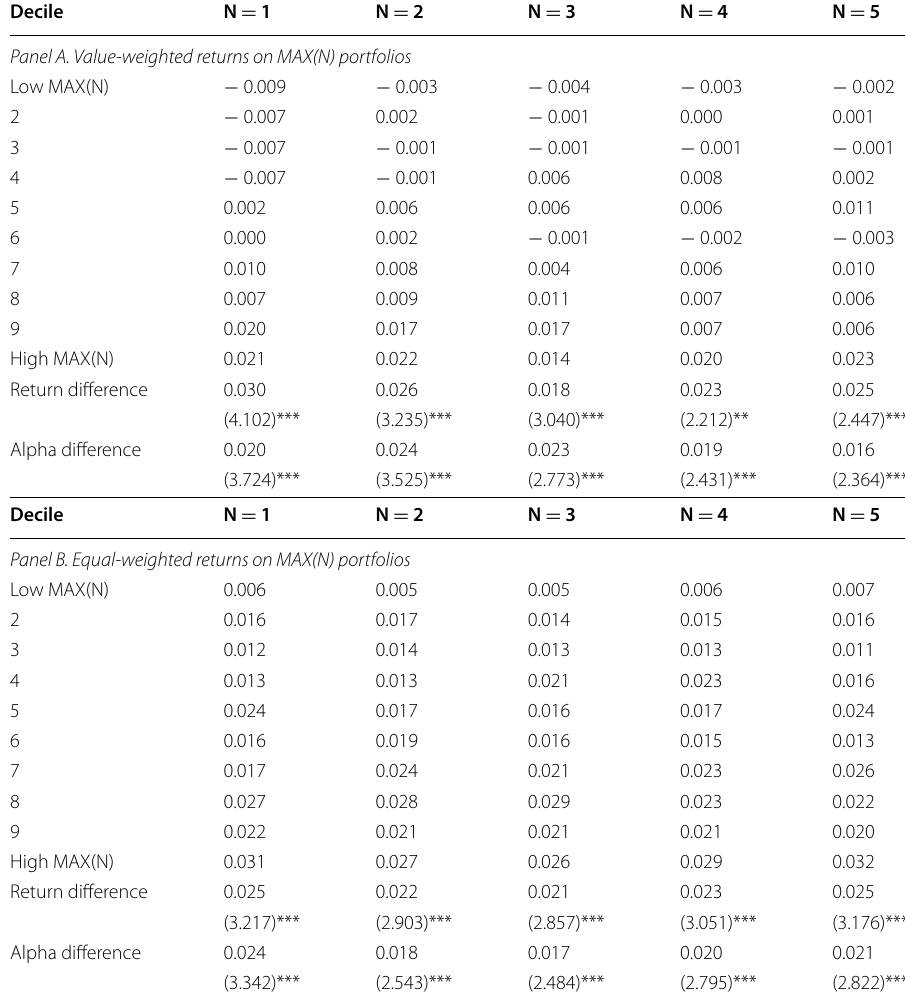
Table 3 Returns on portfolios of cryptocurrencies sorted by multi-day MAX